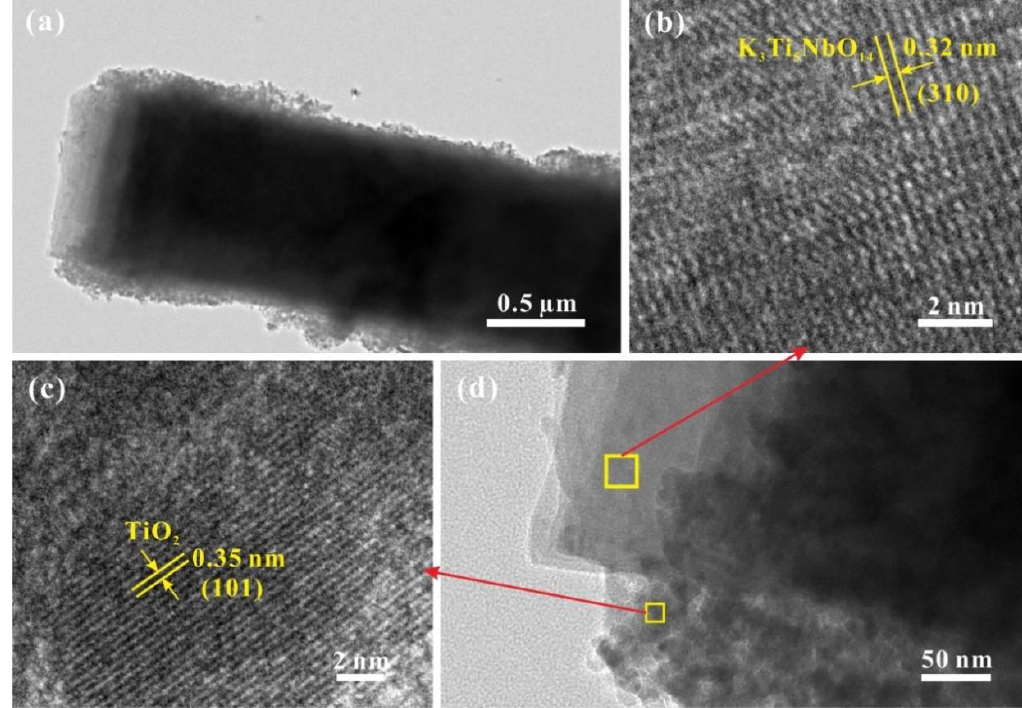
Figure 3. TEM ( a ) and HRTEM ( b – d ) images of STNT3.